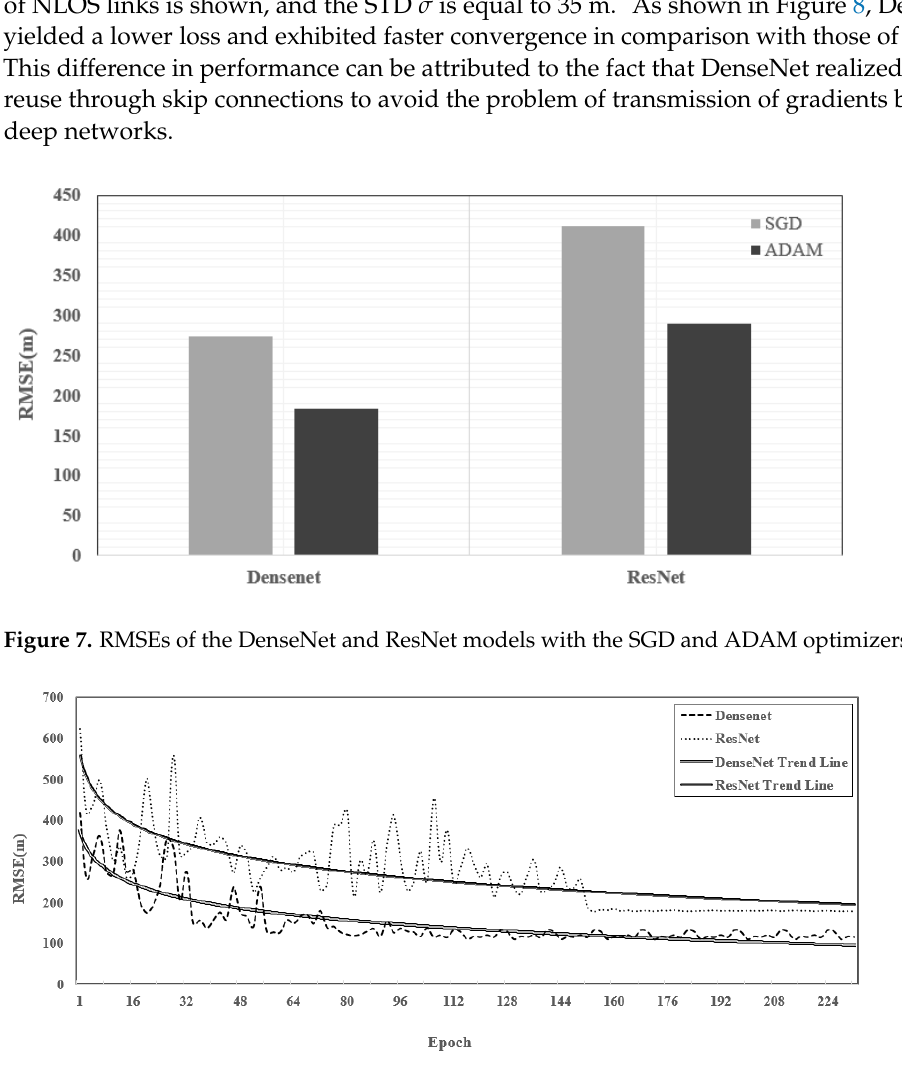
Figure 8. RMSE performance with the training data for DenseNet and ResNet. Table 2. Training options for the DenseNet